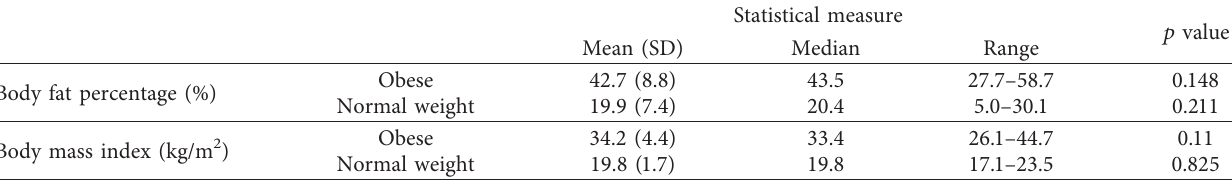
Table 1: Descriptive statistics of body fat percentage and BMI in both obese and normal-weight individuals.